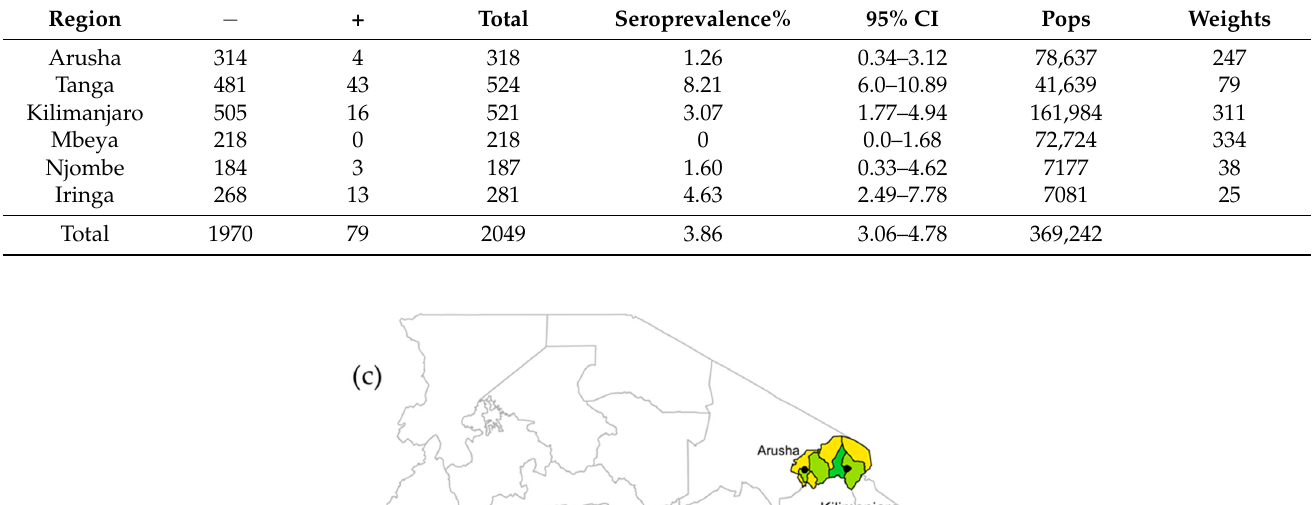
Table 1. Q fever seroprevalence in smallholder dairy cattle across six economical important regions in Tanzania. For each Region, the number of seronegative ( − ) and seropositive (+) from the total sampled animals, the seroprevalence (%) with 95% confidence intervals (CI) and the estimated total dairy cattle population (Pops) in the Region (used to adjust estimates).